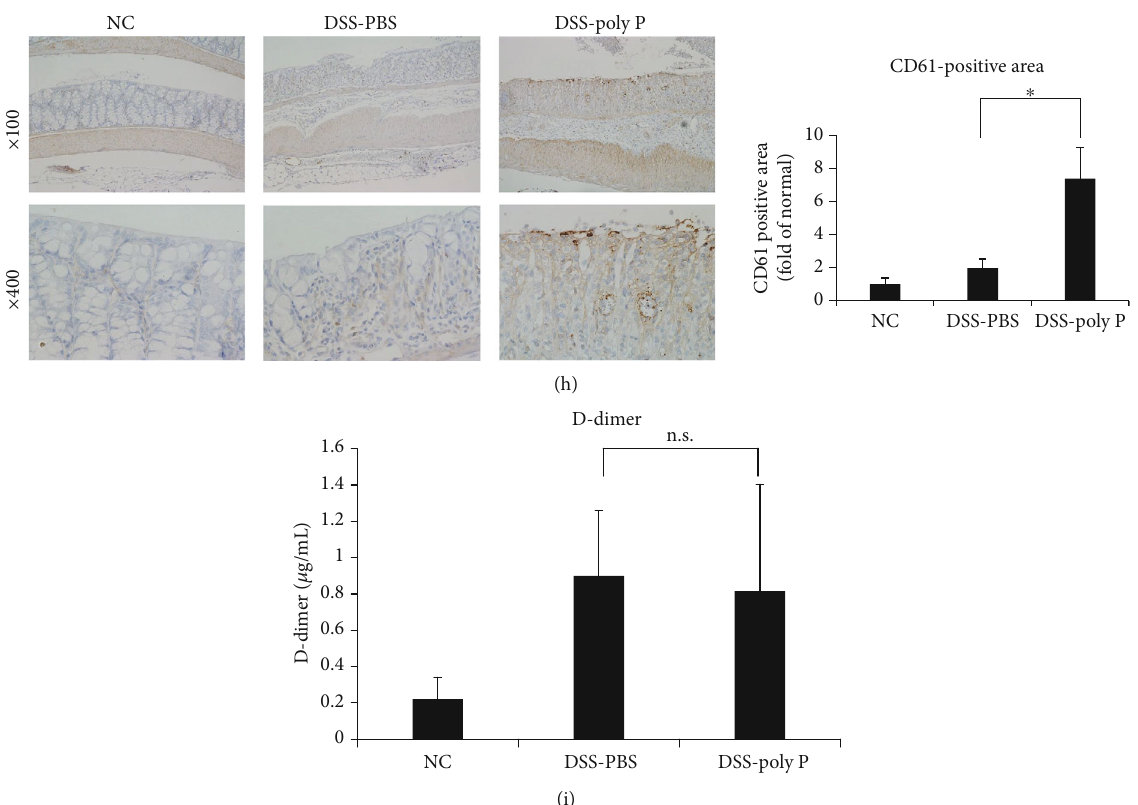
Figure 1: Poly P improved intestinal in fl ammation and enhanced the accumulation of platelets at the intestinal epithelia in a DSS-induced colitis model. A schematic illustration of the curing schedule of the DSS-induced colitis study (a). The length of in fl amed colon (b) and histopathological changes (c) were signi fi cantly improved by poly P in DSS-induced colitis mice. RT-PCR showed that the expression of mRNA of proin fl ammatory cytokines IL1 β (d), TNF (e), and IL6 (f) was signi fi cantly decreased by poly P, while that of IFN- γ (g) was not. Immunohistochemical staining of CD61 showed the accumulation of platelets at the surface of the intestinal epithelia after treatment with poly P (h). An ELISA of plasma D-dimer levels showed no signi fi cant e ff ect on the thrombotic condition by treatment with poly P (i). The error bars and numbers show the standard deviation. ∗ P < 0 : 05 by a one-way ANOVA followed by Fisher ’ s protected least post hoc